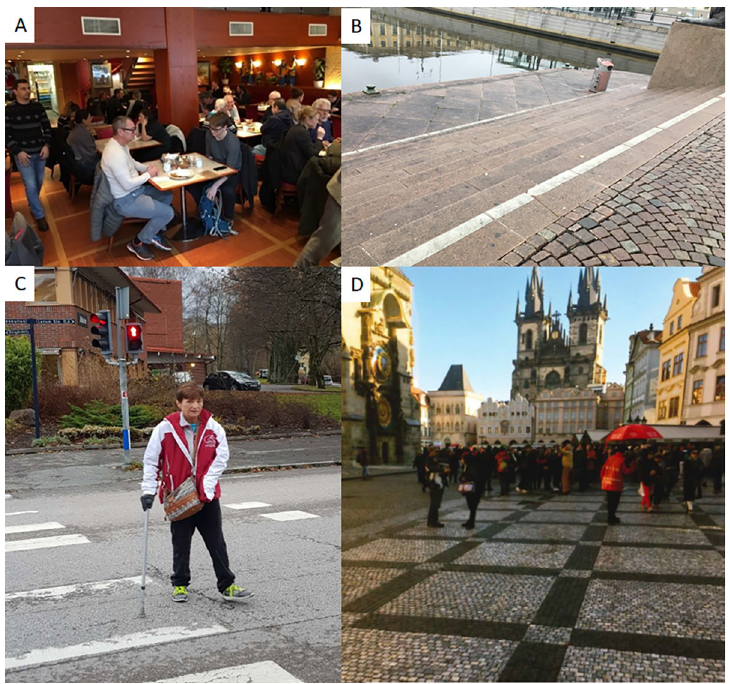
Fig 1. A. Restaurant:”Nice but too loud!” B. Stairs by the water: “Stairs with no handrails are scary” C. Crossing the road: “I cannot pass before the light switches to red” D. Town with church: “A desire to walk every day on a flat surface like